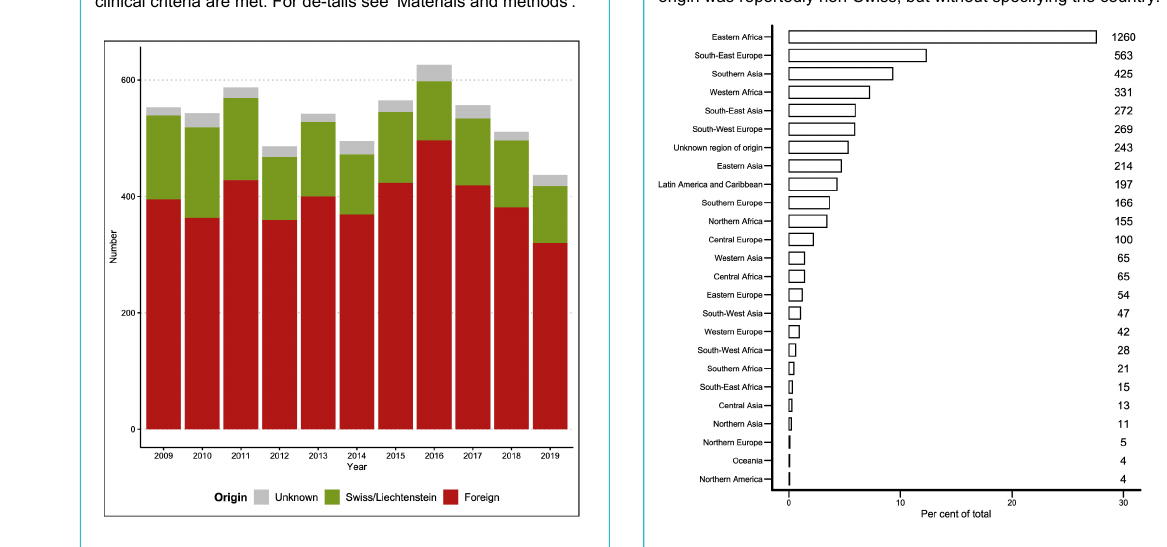
Figure 1: Annual numbers of tuberculosis, by origin, in Switzer- land and Liechtenstein 2009–2019.